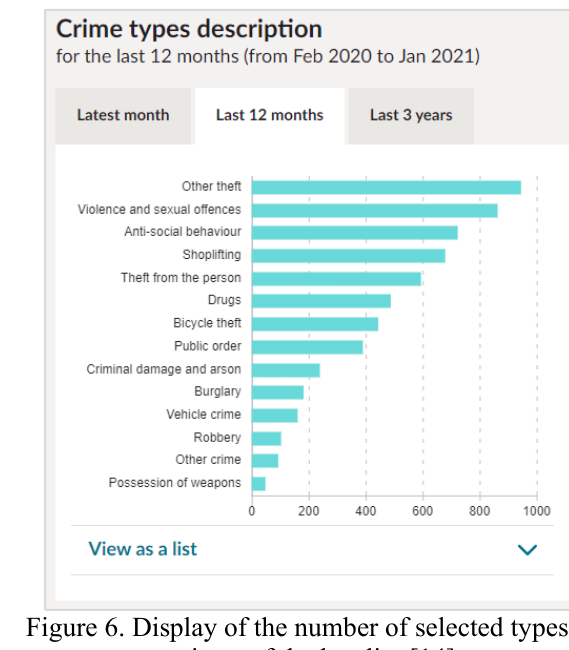
Figure 5. Display of the seasonal state of the crime of the examined locality [14]